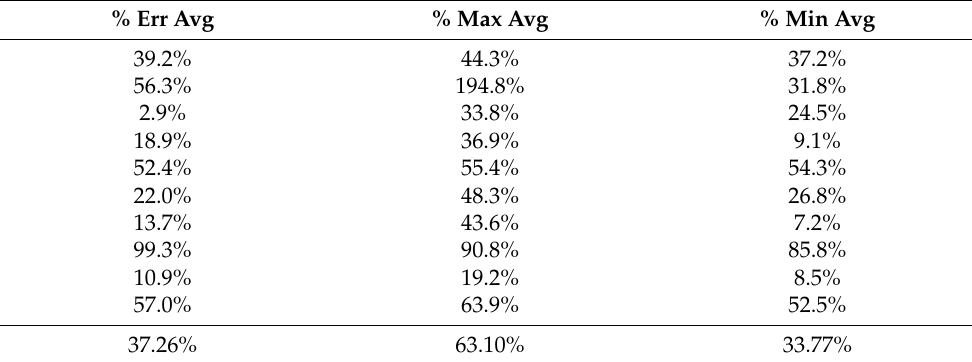
Table A56. Set 1, trials 31–40 data (actual PR value).